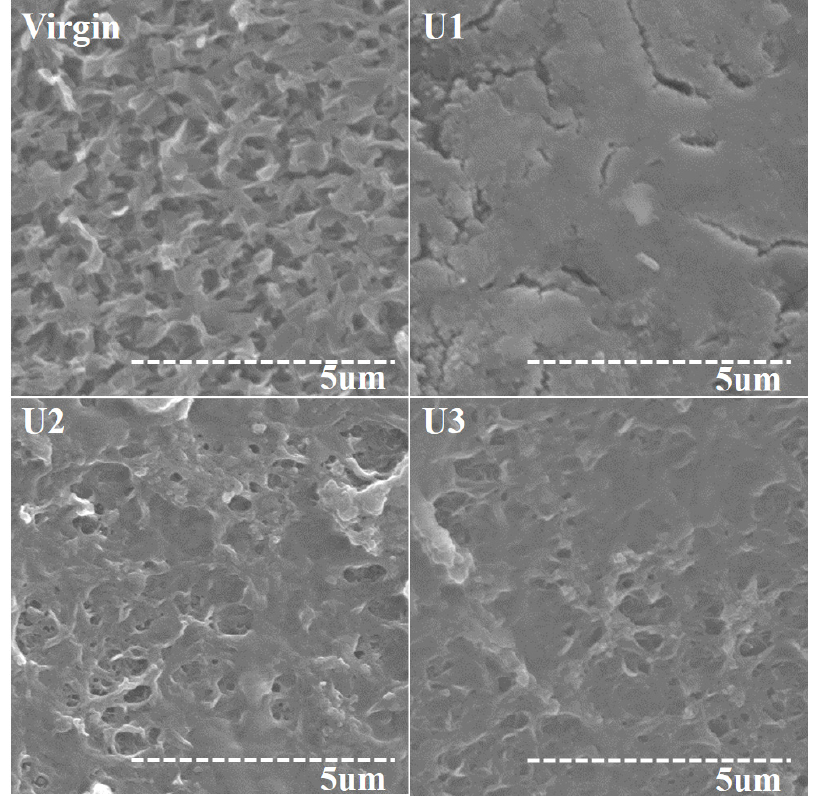
Figure 4. The surface morphology of virgin and fouled membranes.